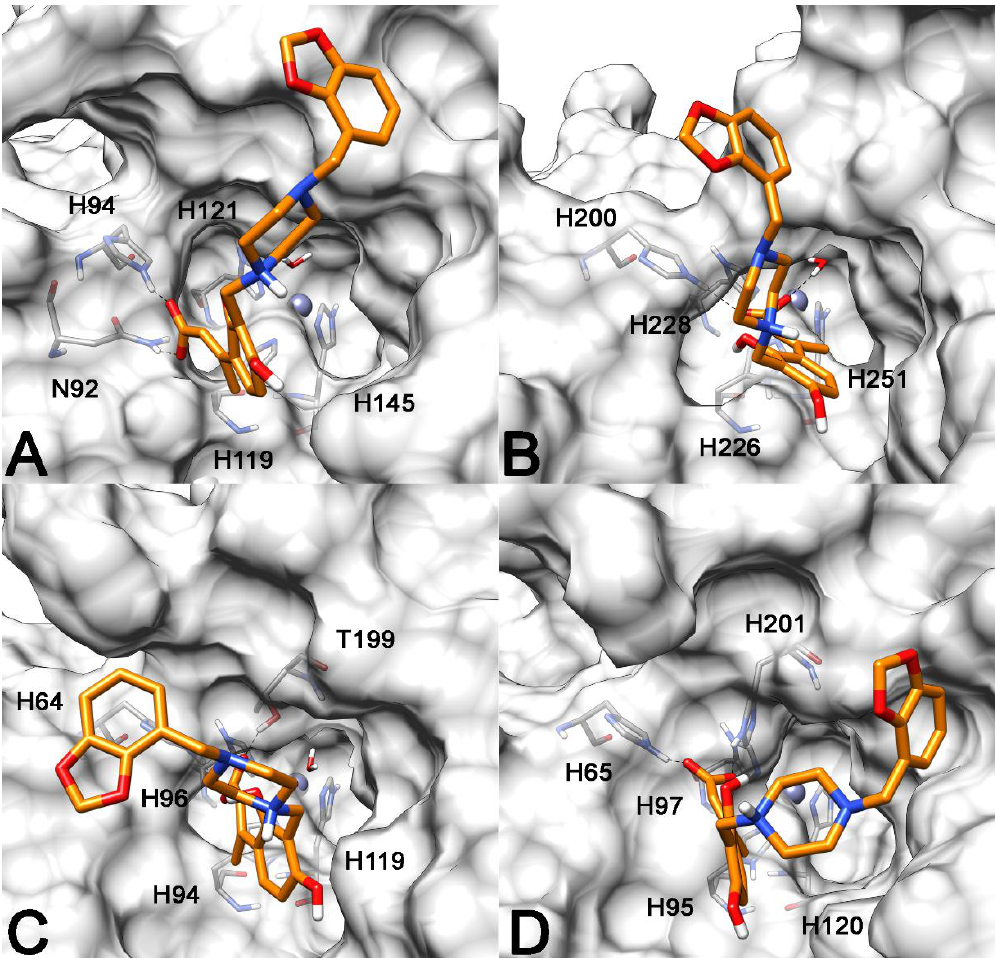
Figure 1. Minimized average structures of compound 13 in hydrolyzed form, in complex with h CA XII ( A ); h CA IX ( B ); h CA II ( C ); and h CA I ( D ). Only residues coordinating the zinc ion or forming H-bond with the ligands are shown in cyan. The protein surface is shown in gray. The zinc ion is shown as a gray sphere.